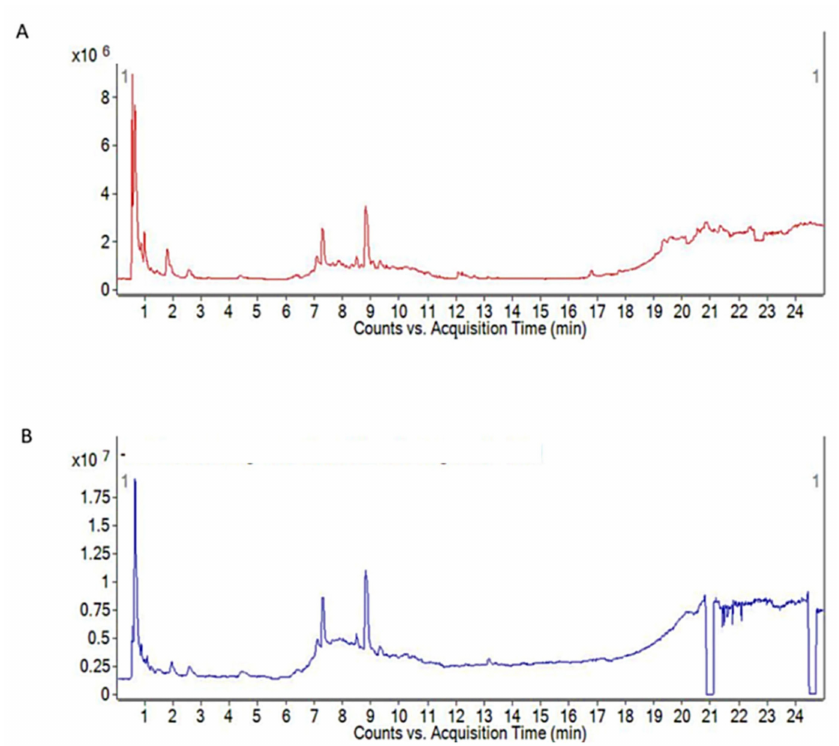
Figure 1. Total ion chromatogram of Manilkara zapota aqueous leaves extract by ESI-Q-TOF MS ( A ) positive ( B ) negative ionization modes. Column: Zorbax Eclipse XDB-C18, 2.1 × 150 mm; mobile phase: 0.1% ( v/v ) of formic acid in water and 0.1% ( v/v ) of formic acid in acetonitrile